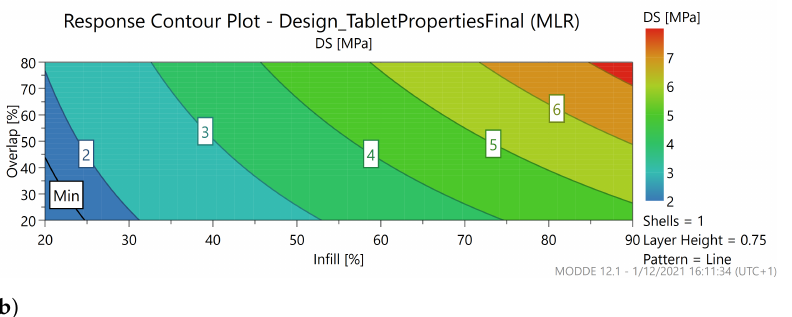
Figure 8. Contour plot of diametral strength (DS) as a function of the overlap (%) and the infill (%). The factor pattern is fixed at the line pattern, and the number of shells is 1. The layer height is either 0.1 ( a ) or 0.3 ( b ). At a layer height of 0.3 mm, a small region in the knowledge space is inaccessible (black line) since it generates caplets with defective mechanical properties (DS < 1.7